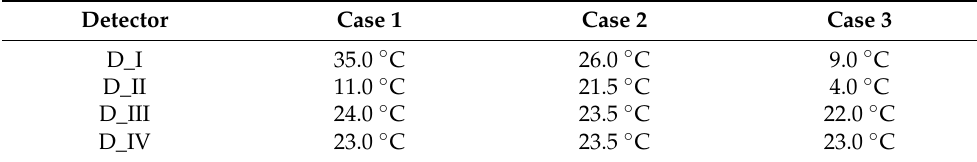
Table 3. The temperatures set on the individual